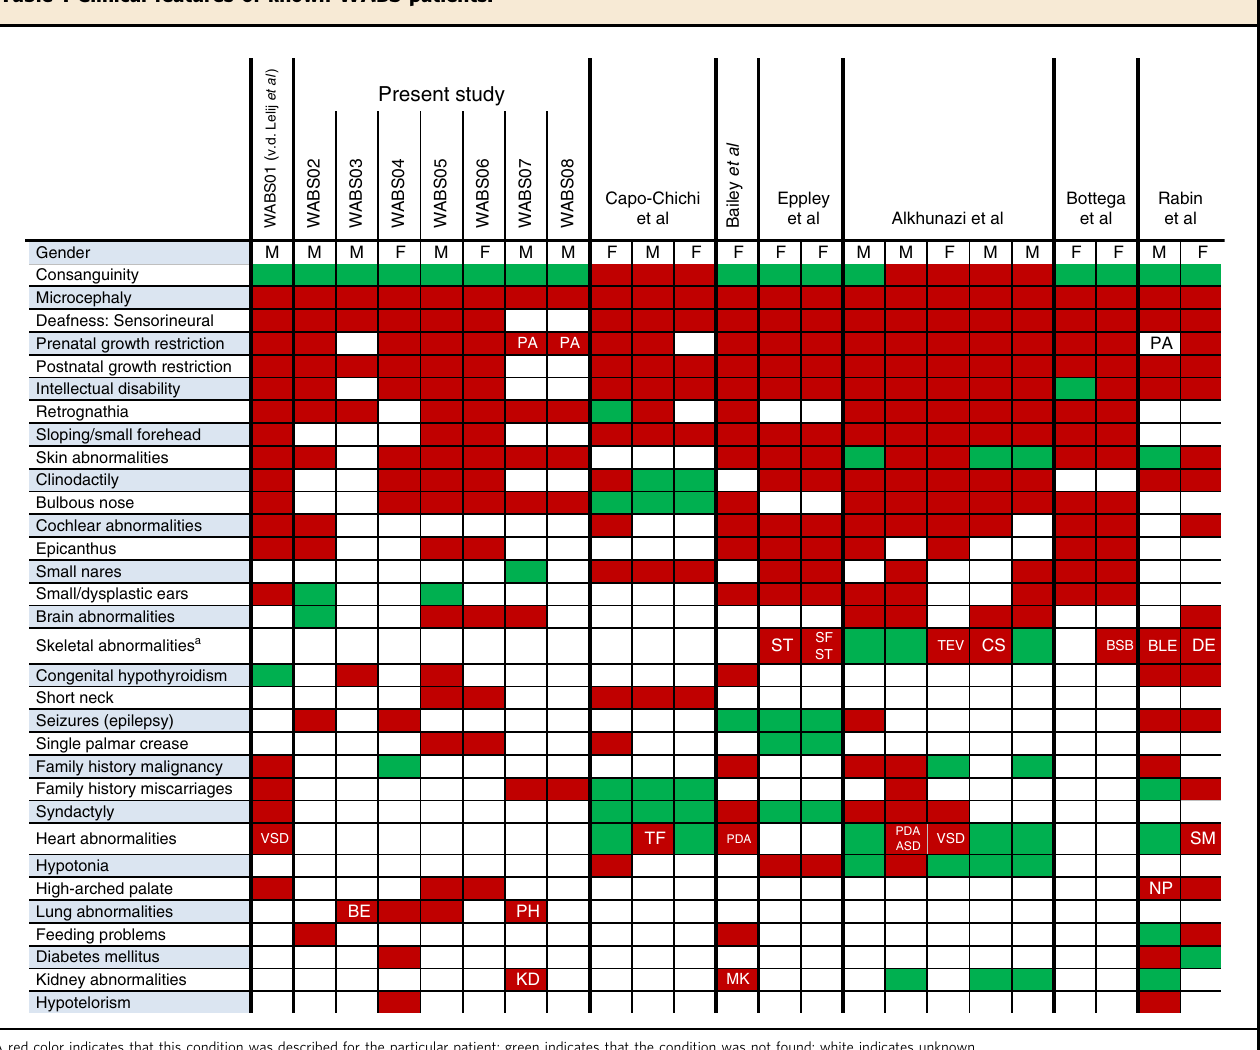
Table 1 Clinical features of known WABS